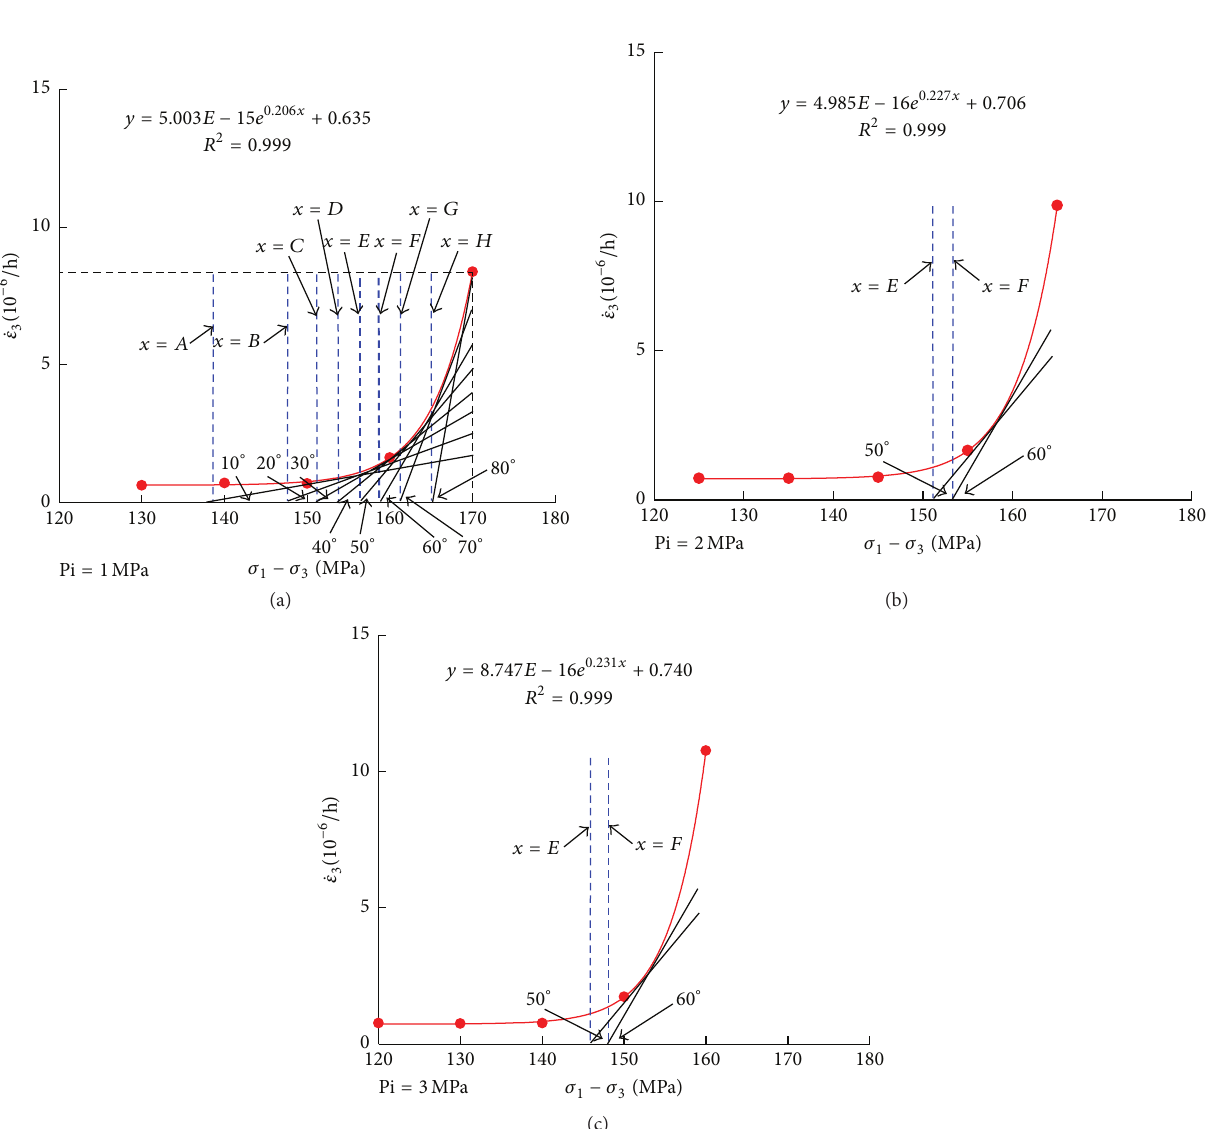
rate exhibit an intersection point. It is the critical point of rock compression and volumetric dilatancy. Based on the actual deformation characteristics of the samples, the long- term strength is defined by the stress at the intersection